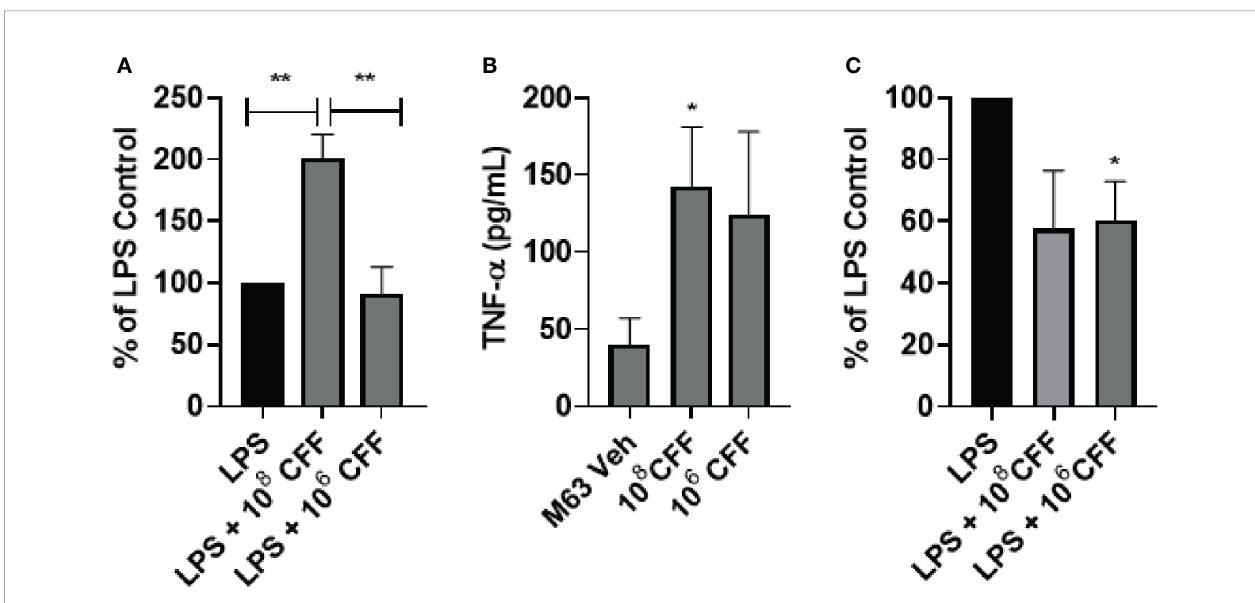
FIGURE 5 | L. acidophilus cell free fi ltrate (CFF) has concentration-dependent effects on TNF a secretion in THP-1 monocytes and monocyte derived macrophages. THP-1 monocytes or monocyte derived macrophages were incubated with L. acidophilus 10 8 or 10 6 CFF alone or with cells 1 h after LPS stimulation. Supernatants were obtained 20 h after incubation and analyzed for levels of TNF a using ELISA. (A) L. acidophilus 10 8 CFF increased TNF a secretion in LPS-stimulated THP-1 monocytes, but 10 6 CFF had no effect. (B) In THP-1 monocyte derived macrophages, L. acidophilus 10 8 CFF alone promoted TNF a production while 10 6 CFF did not signi fi cantly alter TNF a production. (C) When THP-1 monocyte derived macrophages were stimulated with 50 ng/mL LPS 1 h prior to L. acidophilus CFF treatment, 10 6 CFF signi fi cantly attenuated TNF a production. Data are mean ± s.e.m. % of LPS Control data are mean ± s.e.m. percent change from LPS control adjusted to 100%. *p < 0.05, **p < 0.01 compared to controls; THP-1 monocytes n = 5 independent experiments; THP-1 monocyte derived macrophages n = 5 independent experiments; THP-1 monocyte derived macrophages % of LPS control n = 4 independent